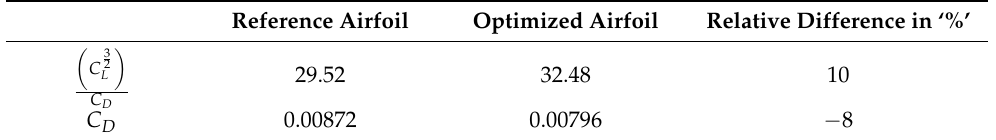
Table 3. Comparison of aerodynamic endurance and minimized drag of the reference and opti- mized airfoils.